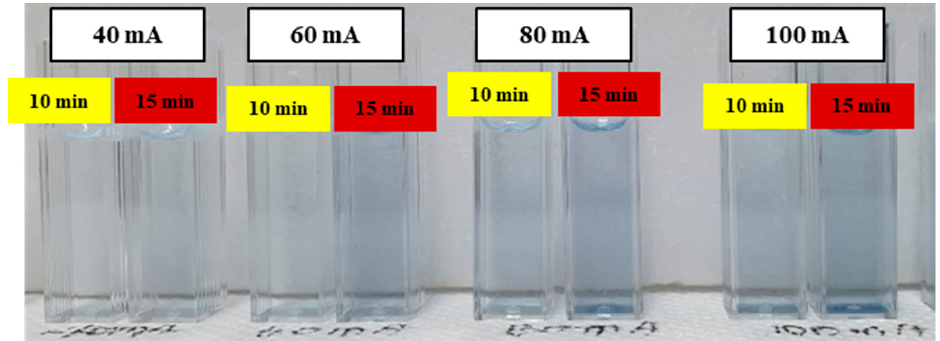
Figure 13. Pretreated and blue-colored analytes (2 mg/500 mL) as functions of the pretreatment time and the UV LED array operating current.